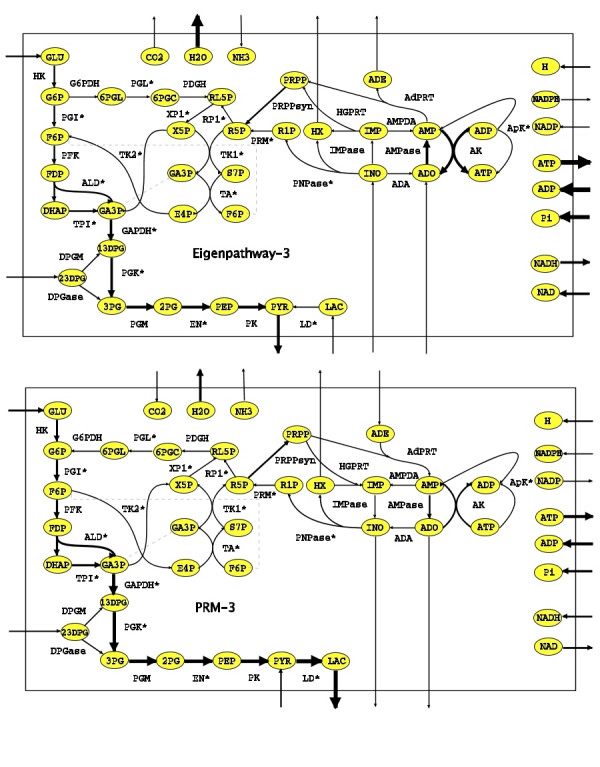
The third eigenpathway derived from SVD of the extreme pathways matrix and the third PRM derived from SVD of the samples matrix for the hRBC metabolic network. The relative values of the flux values is indicated by the thickness of the arrows between metabolites. The metabolite and reaction definitions are given in Table 1 and Table 2.